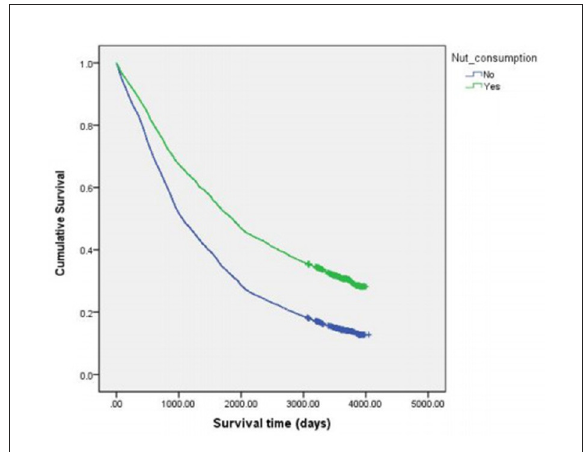
FIGURE2 Kaplan-Meier survival curves by nut